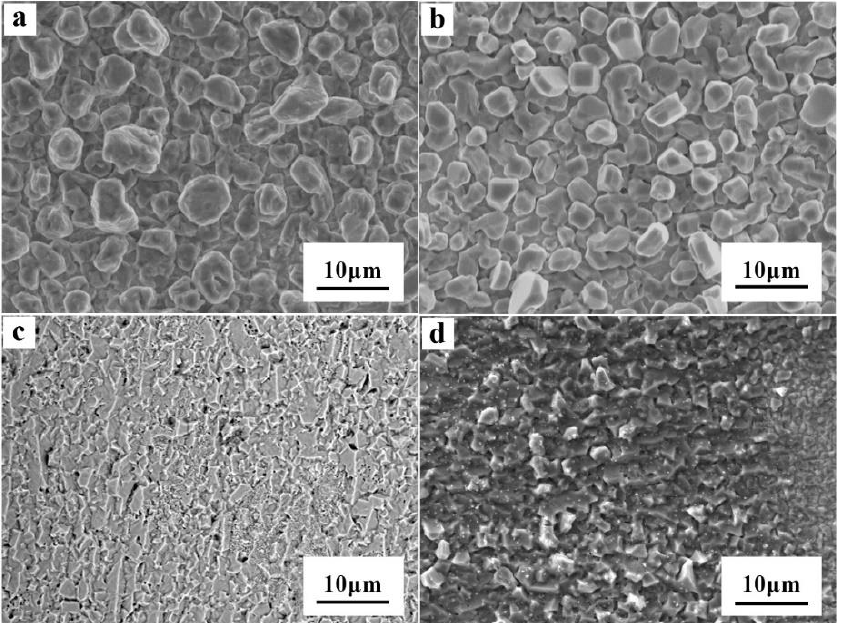
Figure 5. The microscopic morphologies of the aluminum electrodeposits obtained in AlCl 3 -NaCl-KCl (80-10-10 wt.%) molten salts electrolyte with different additives, ( a ) no additives, ( b ) 1% TMACl, ( c ) 1% TMACl + 5% NaI and ( d ) 1% TMACl + 10% NaI.